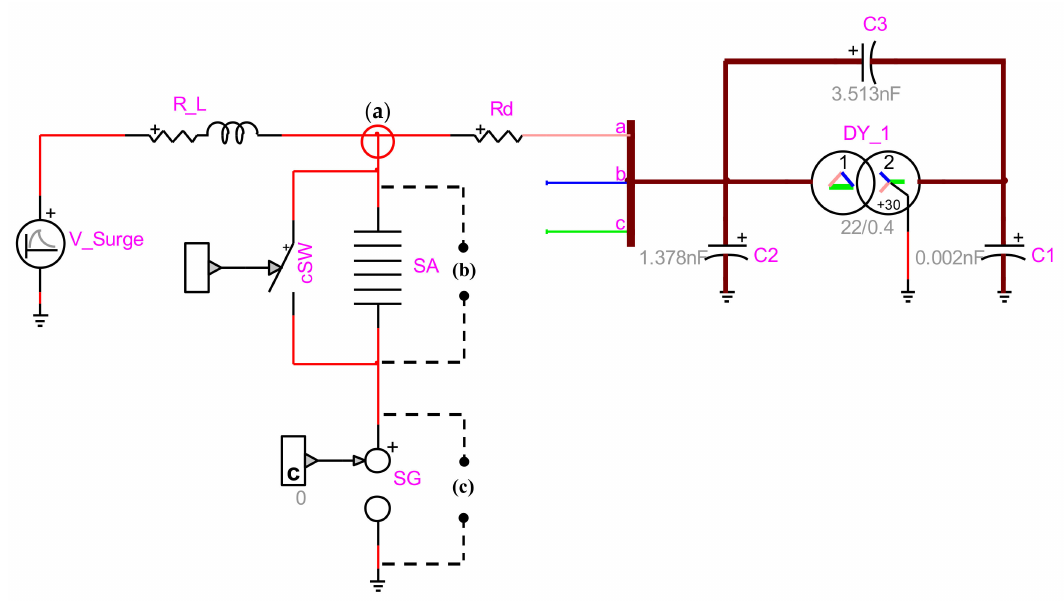
Figure 7. Series connection of surge arrester (SA) and spark gap (SG); ( a ) measurement point for overvoltage stress, ( b ) adding / eliminating the SA by disconnecting / connecting this wire, and ( c ) adding / eliminating the SG by disconnecting / connecting this